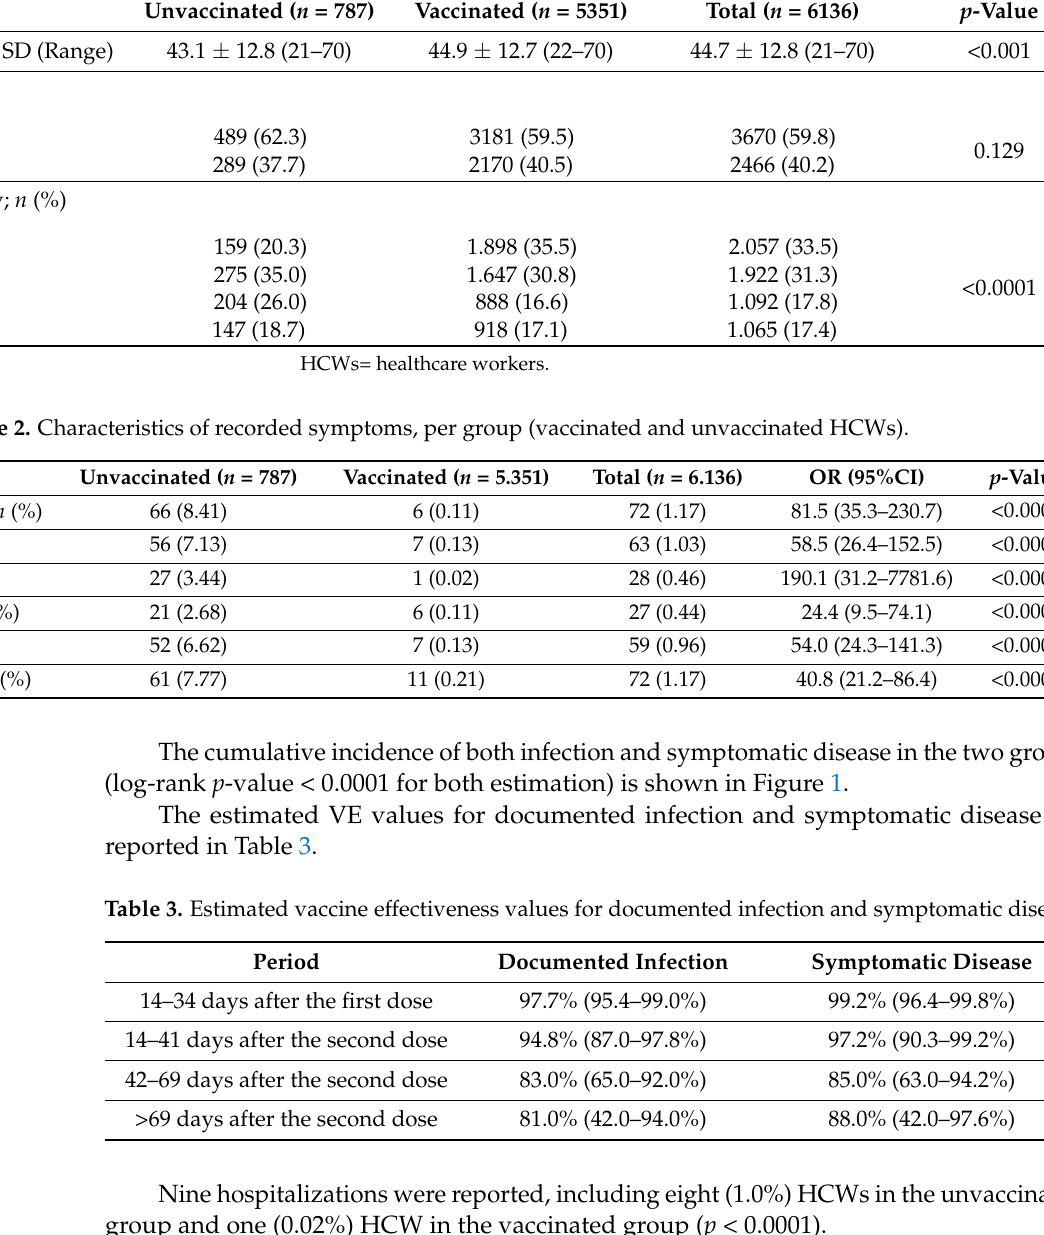
Table 1. Characteristics of the two study groups (vaccinated and unvaccinated HCWs) at baseline. Variable.